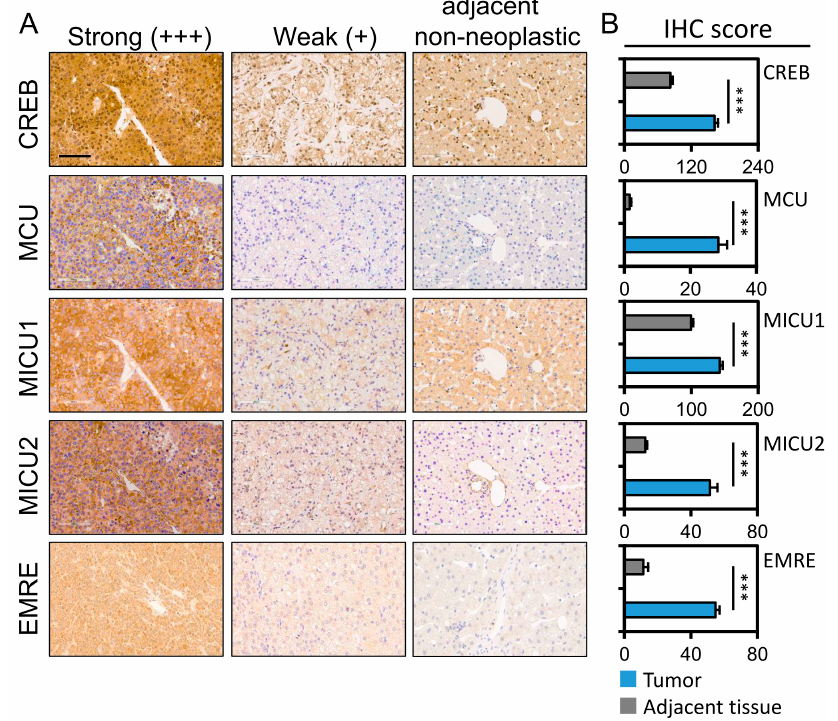
Figure 3. Immunoreactivity of CREB, MCU, MICU1, and MICU2 in hepatocellular carcinoma (HCC). ( A ) The representative photomicrographs of CREB, MCU, MICU1, and MICU2 expression for adjacent non-neoplastic, weak (+), and strong (+++) staining in HCC tissues. ( B ) The IHC scores of CREB, MCU, MICU1 and MICU2 expression in hepatocellular carcinoma tissue and matched adjacent normal liver tissue. *** p < 0.001. Scale bars 200 μ m.